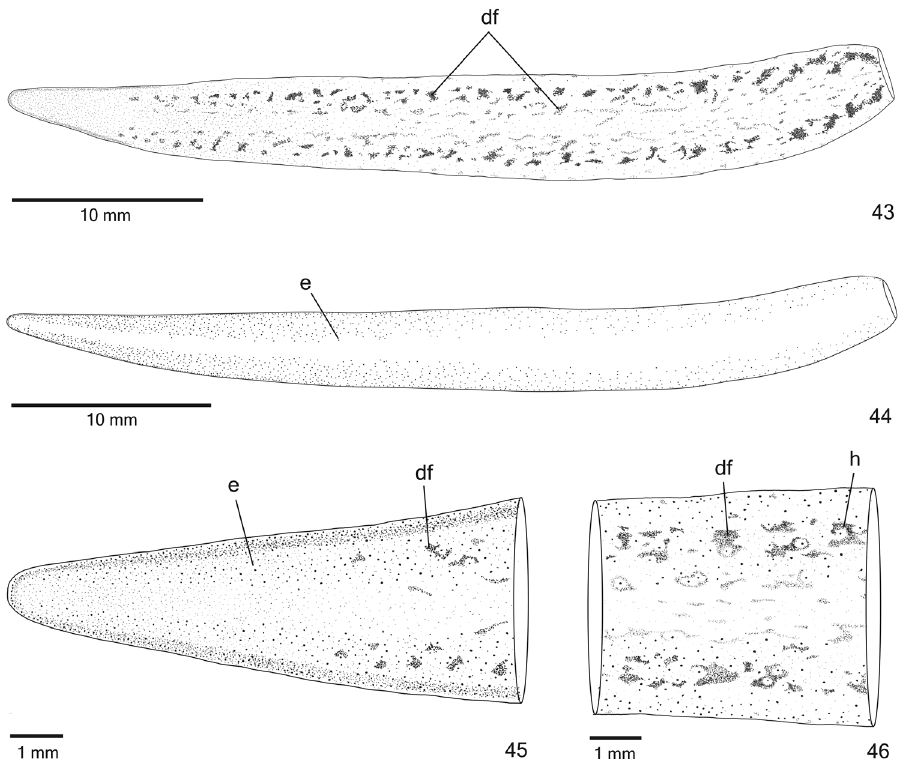
Figures 43–46. Cratera aureomaculata sp. n., holotype, dorsal view, 43 pattern of pigmentation 44 eye pattern 45–46 anterior extremity ( 45 ) and median third of body ( 46